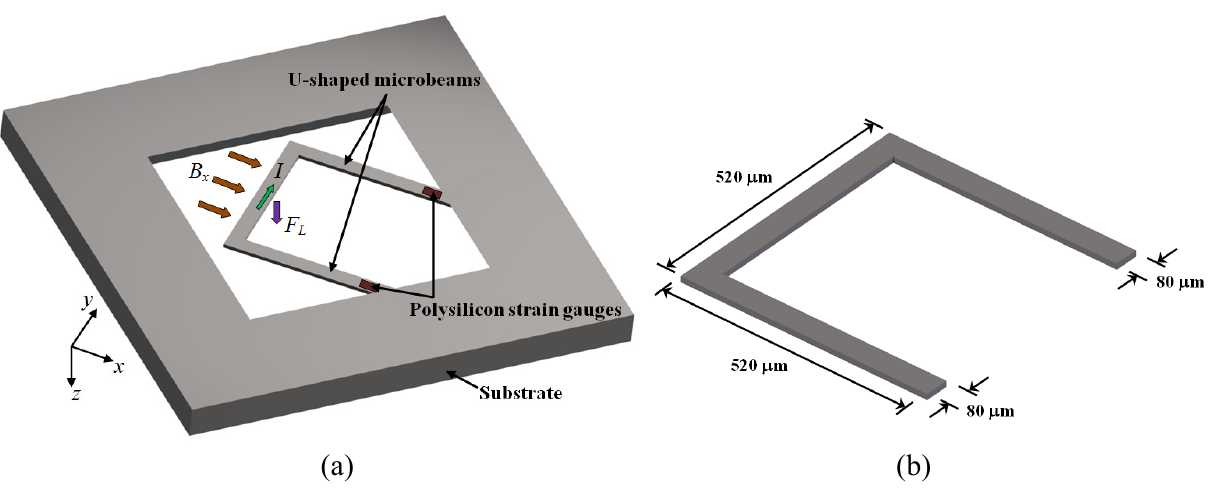
Figure 5. (a) Schematic view of operation principle and (b) dimensions of the resonant U- shaped microbeams used by the magnetic field sensor designed by Bernoulle et al .